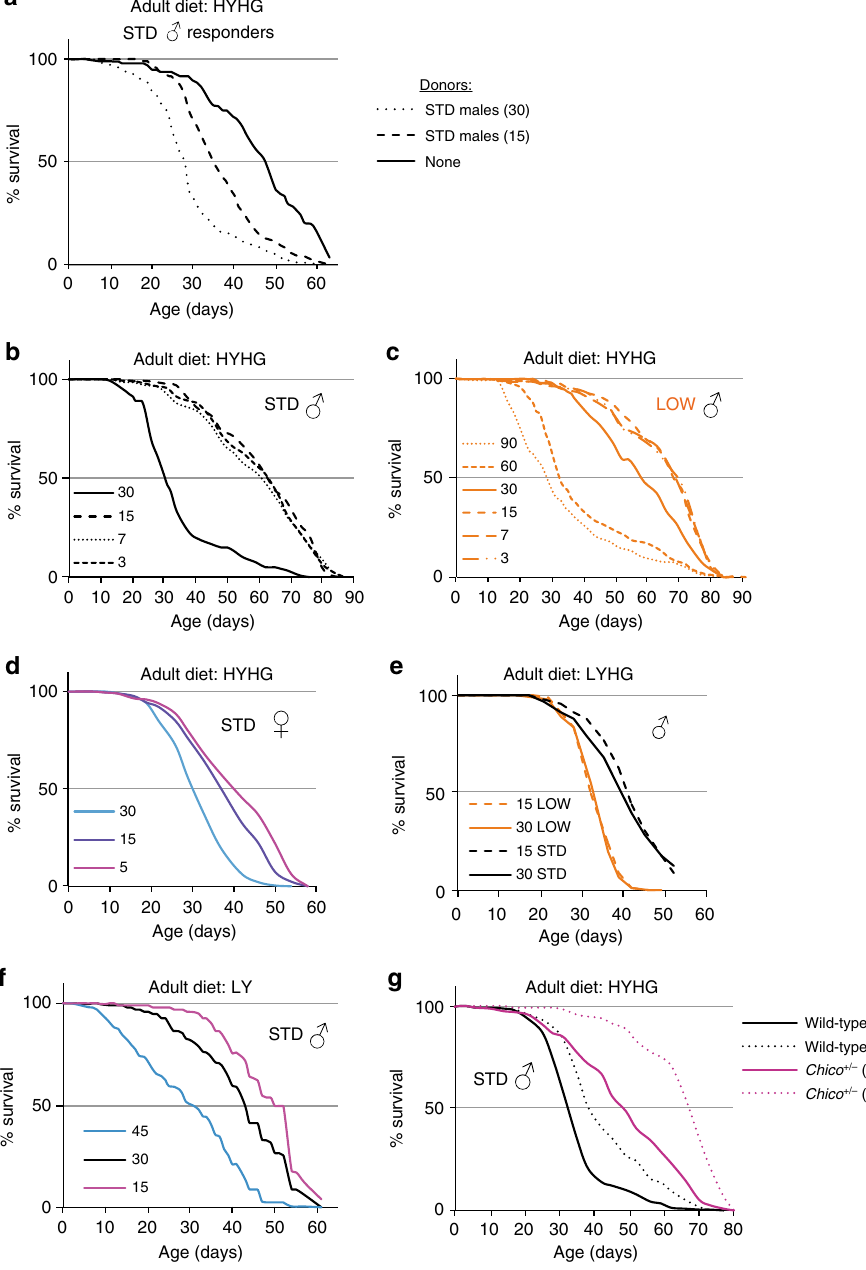
Fig. 9 Effects of housing density, diet and chico heterozygosity upon lifespan. a Survival of STD responder males in vials preconditioned with 15 or 30 STD donor males (15 responders per vial). Note that the survival curves for no donors and 30 STD male donors are the same as those shown in Fig. 4d as these experiments were done in parallel. b – d , Survival of STD males b LOW males c and STD females d on HYHG diet at housing densities ranging from 3 to 90 fl ies per vial. e Survival of STD and LOW males on LYHG diet at 15 or 30 fl ies per vial. f Survival of STD males on LY diet at 15, 30 or 45 fl ies per vial. g Survival of chico +/ − and chico +/+ STD males, housed on HYHG at densities of 15 or 30 per w 1118 wild-type fl ies (Figs. 3d, 4d – f, 5f) or yw wild-type fl ies (Fig. 4b, c). For the (Brian Drewitt), 58.5g glucose (VWR, Cat. No. 10117HV), 66.3 g cornmeal (Brian survival curves for PromE TS > desat1 RNAi in Fig. 5f, the controls were not isogenic Drewitt), 23.4 g autolysed yeast extract (Brian Drewitt) and 19.5 mL of antimycotic so comparisons should be made between adults of the same genotype at different housing densities, not between different genotypes. Additional fl y strains used in this study were obtained from the Bloomington Drosophila Stock Center at Indiana University and the Vienna Drosophila Resource Center. Diets and dietary manipulations . All larval and adult diets contained cornmeal- glucose-yeast-agar and antimycotic agents and were prepared by boiling not autoclaving. All fl y lines were reared on standard (STD) diet for at least 10 gen- erations prior to experiments. STD diet (~2%wv − 1 yeast) consists of 7.02g agar